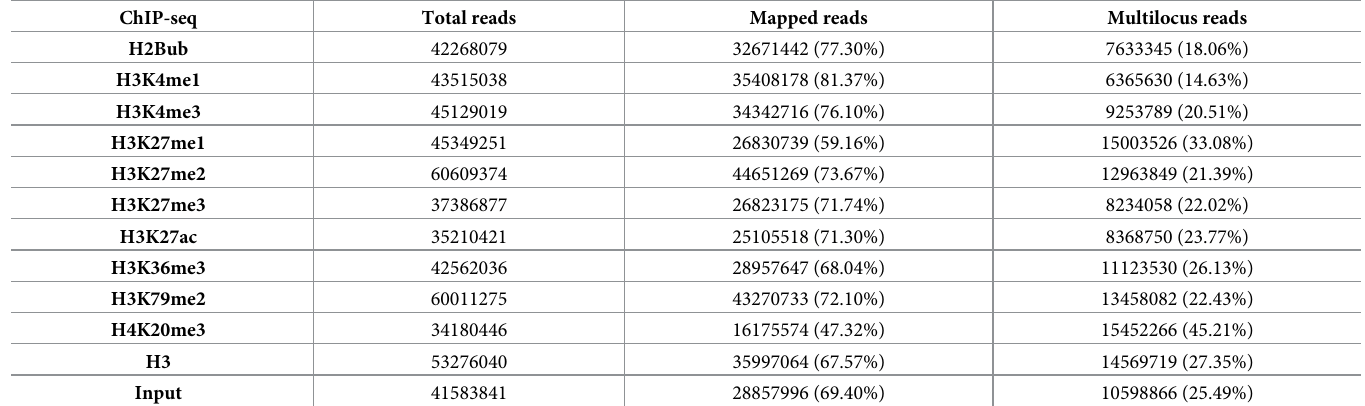
Table 4. Information on ChIP-seq experiments produced in this study.